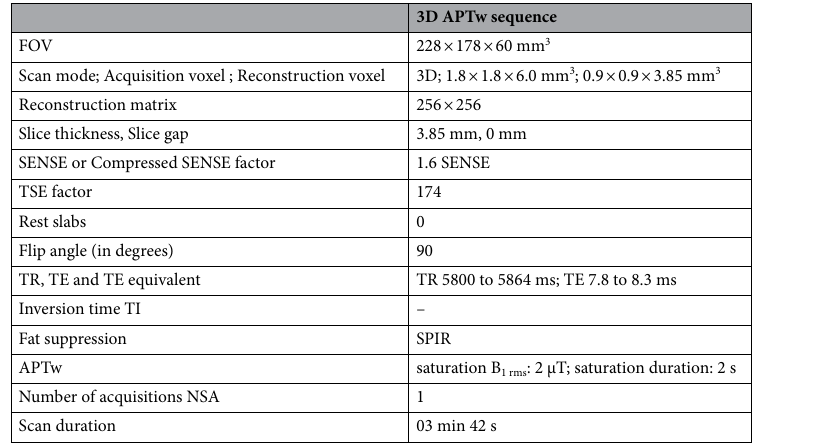
Table 1. APTw MRI sequence